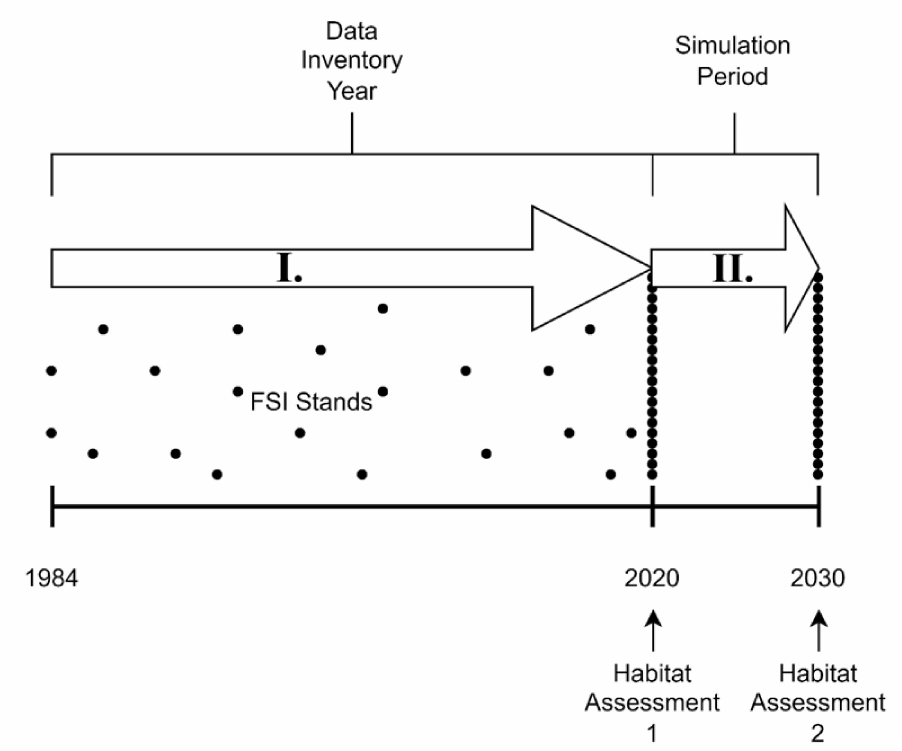
Figure 2. Schematic of two stages of stand advancement/growth and habitat assessment based on planned sustainable timber harvest in Minnesota, USA. ( I. ) Forest stand inventory (FSI) stands of various inventory years advance to a 2020 baseline with stand age and size class transition protocols. ( II. ) Stand Exam List stands enter simulated harvest scenarios while remaining FSI stands continue